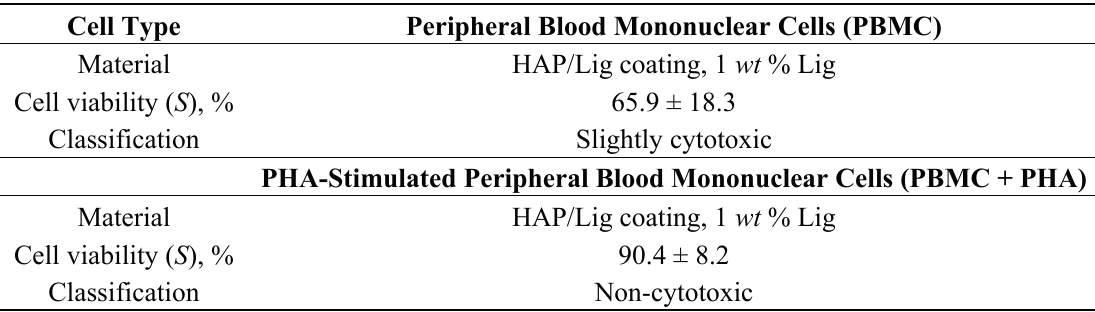
Table 2. Cell survival of peripheral blood mononuclear cells (PBMC) and PBMC phytohemagglutinin (PHA)-stimulated in the presence of sintered HAP/Lig (1 wt % Lig) coatings Reprinted from [38] with permission. Copyright Elsevier